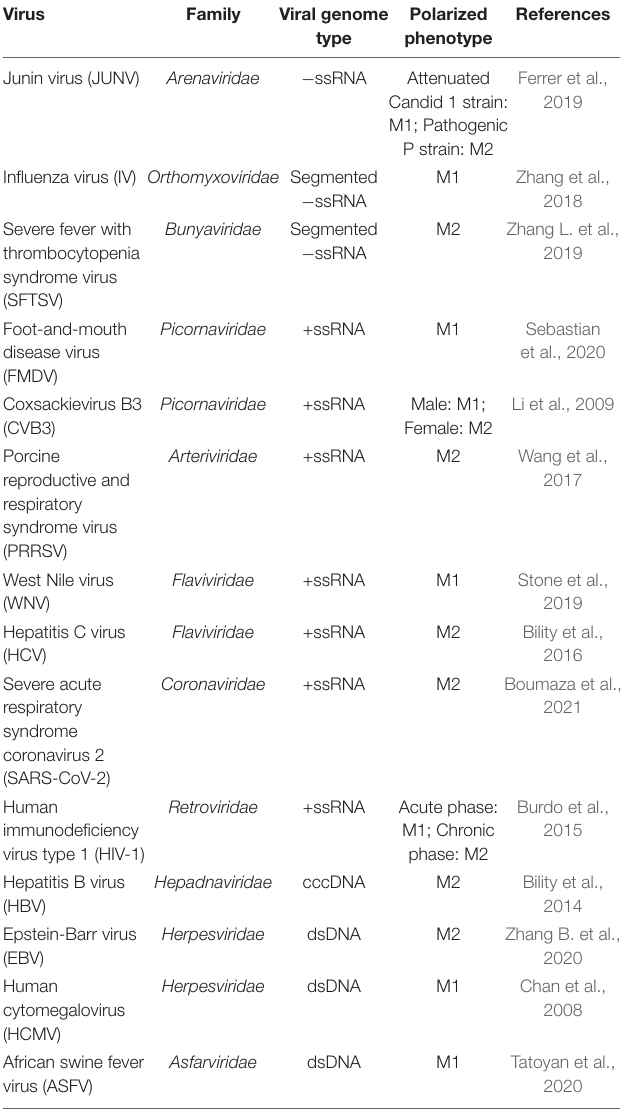
TABLE 1 | Summarization of virus-induced macrophage